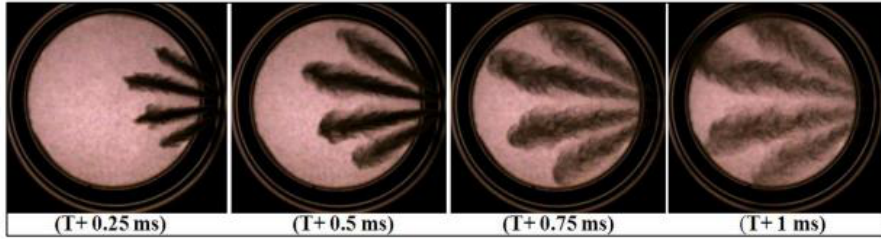
Figure 14. Images taken in the stationary environment chamber.